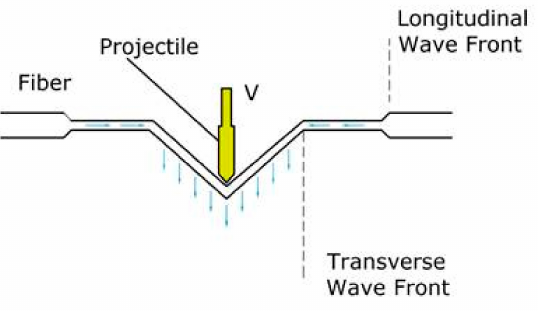
Figure 7. Transverse and longitudinal waves resulted in fiber from the bullet [35].